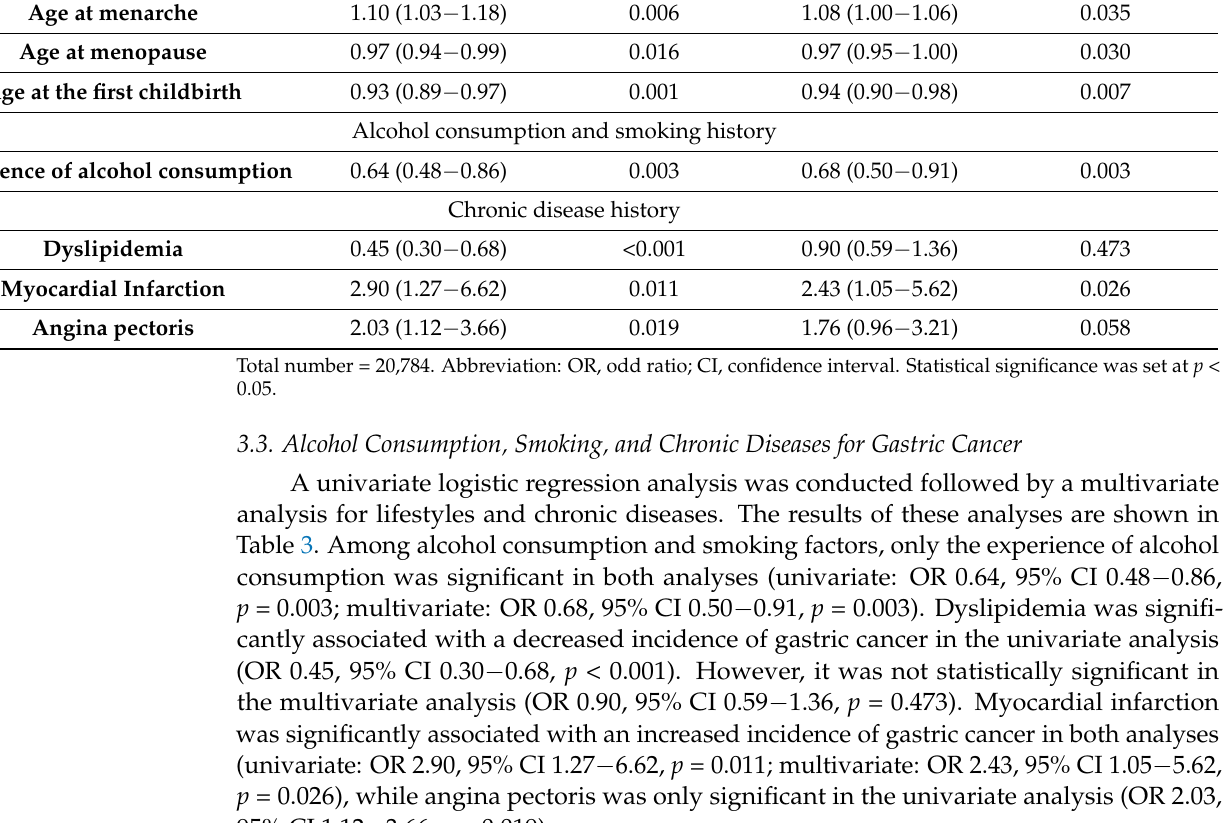
Table 3. Logistic regression analyses for menstrual, reproductive, and other factors. Univariate Multivariate OR (95% CI) p -Value OR (95% CI) p -Value Menstrual and reproductive